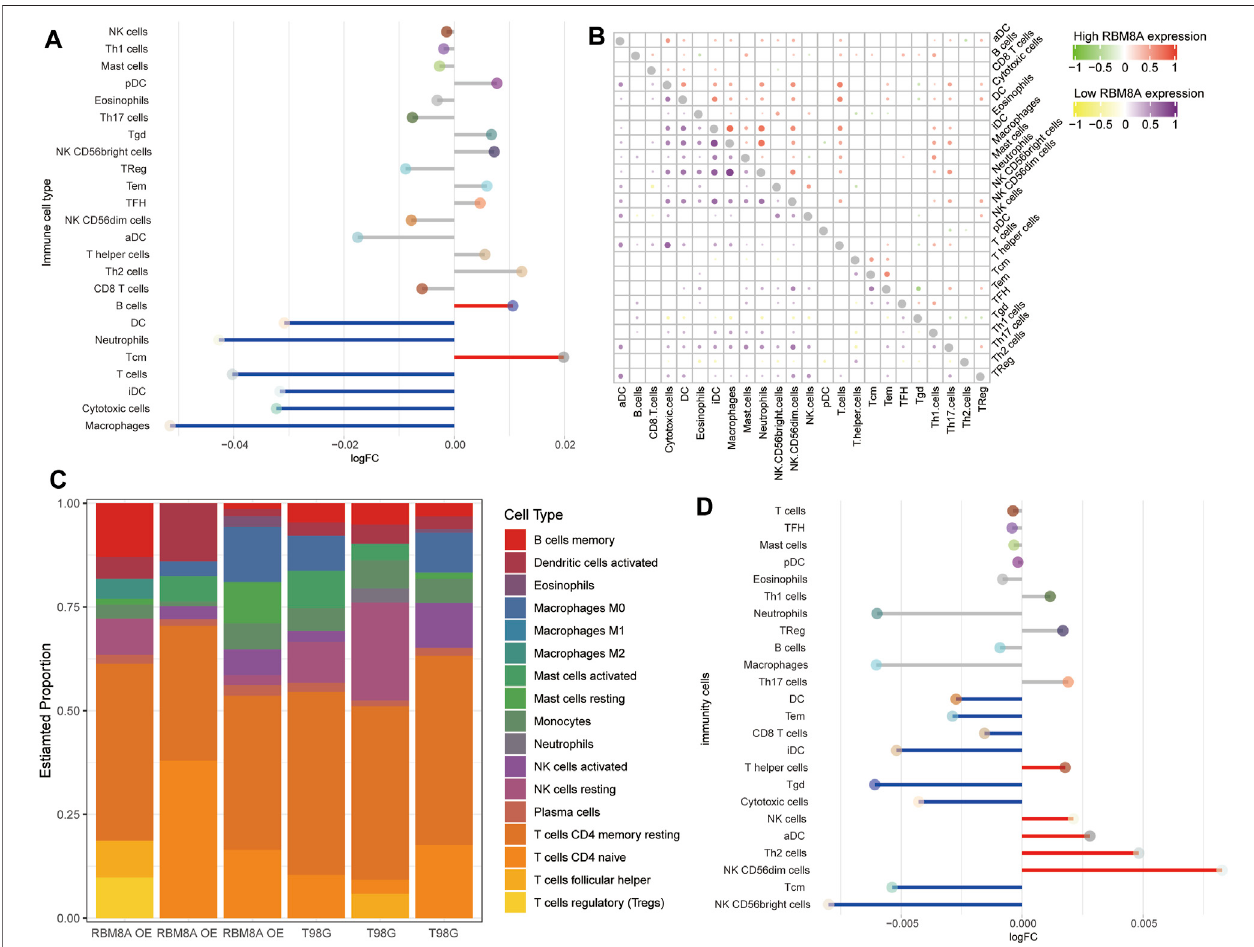
FIGURE 9 | Immune cell in fi ltration associated with RBM8A expression in GBM. (A) Levels of in fi ltration by 24 immune cell types in RBM8A high and RBM8A low groups in TCGA. (B) Correlation of immune cell in fi ltration between the RBM8A high and RBM8A low groups. (C) Proportions of 21 immune cell types in RBM8A- overexpressing T98G cells and controls, as detected by the CIBERSORT algorithm. (D) Levels of in fi ltration by 24 immune cell types in RBM8A-overexpressing and control T98G